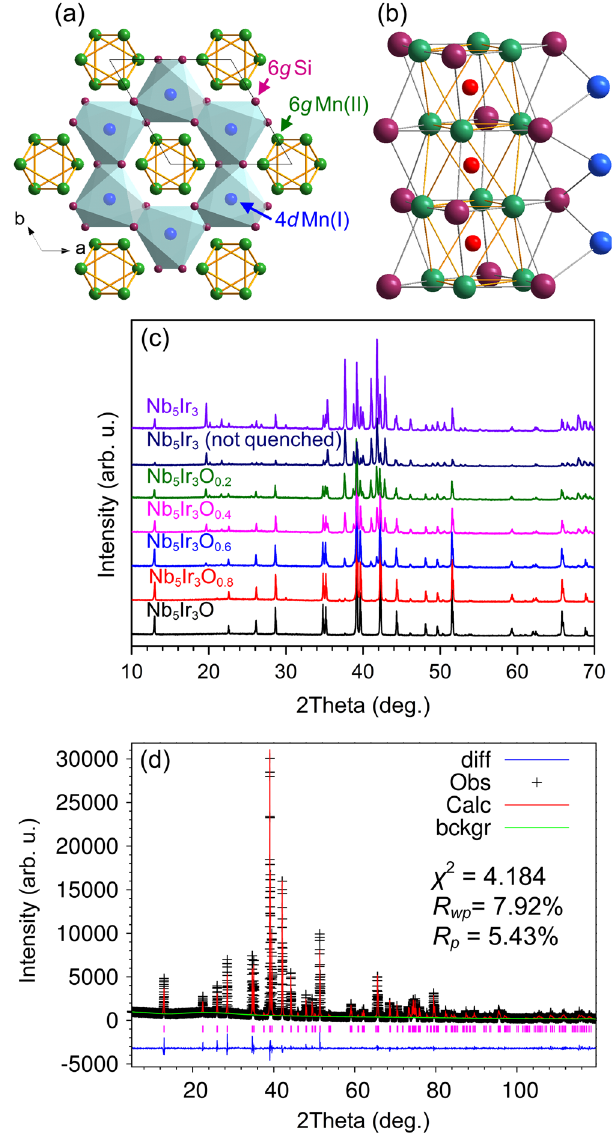
Fig. 1 An illustration of the Mn 5 Si 3 -type crystal structure and x-ray diffraction patterns for Nb 5 Ir 3 . a Shaded polyhedral Si ( the plum spheres ) complexes are twisted Si 6 trigonal prisms which accom- modate Mn(I) atoms ( the blue spheres ) in the centre. b The 6 g Mn(II) atoms ( the green spheres ) form chains of confacial trigonal antiprisms in which the channel space can be fi lled by guest atoms ( the red spheres ), while the 4 d Mn(I) atoms construct another linear structure. c XRD patterns collected on a series of Nb 5 Ir 3 O x (0 ≤ x ≤ 1) phases quenched in liquid nitrogen unless speci fi ed. d A Rietveld re fi nement analysis of data for single-phased Nb 5 Ir 3 O